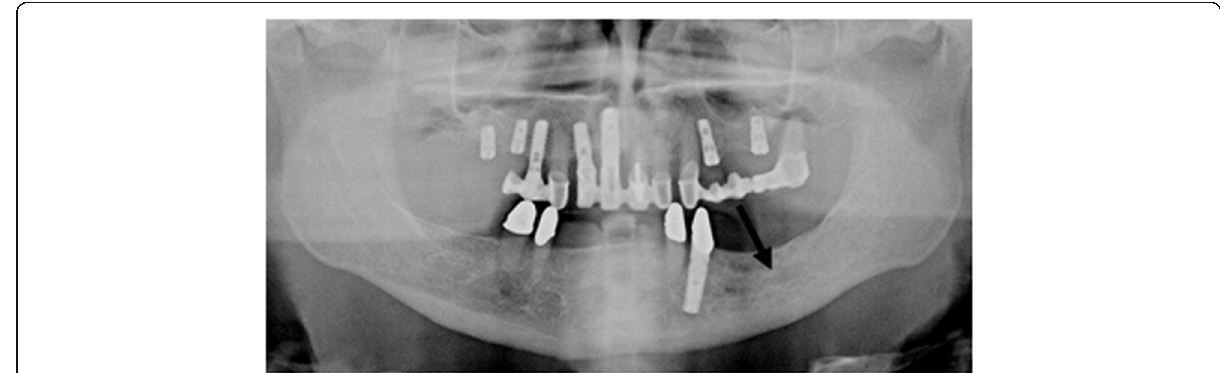
Fig. 1 PR: region 36 canal roof not visible